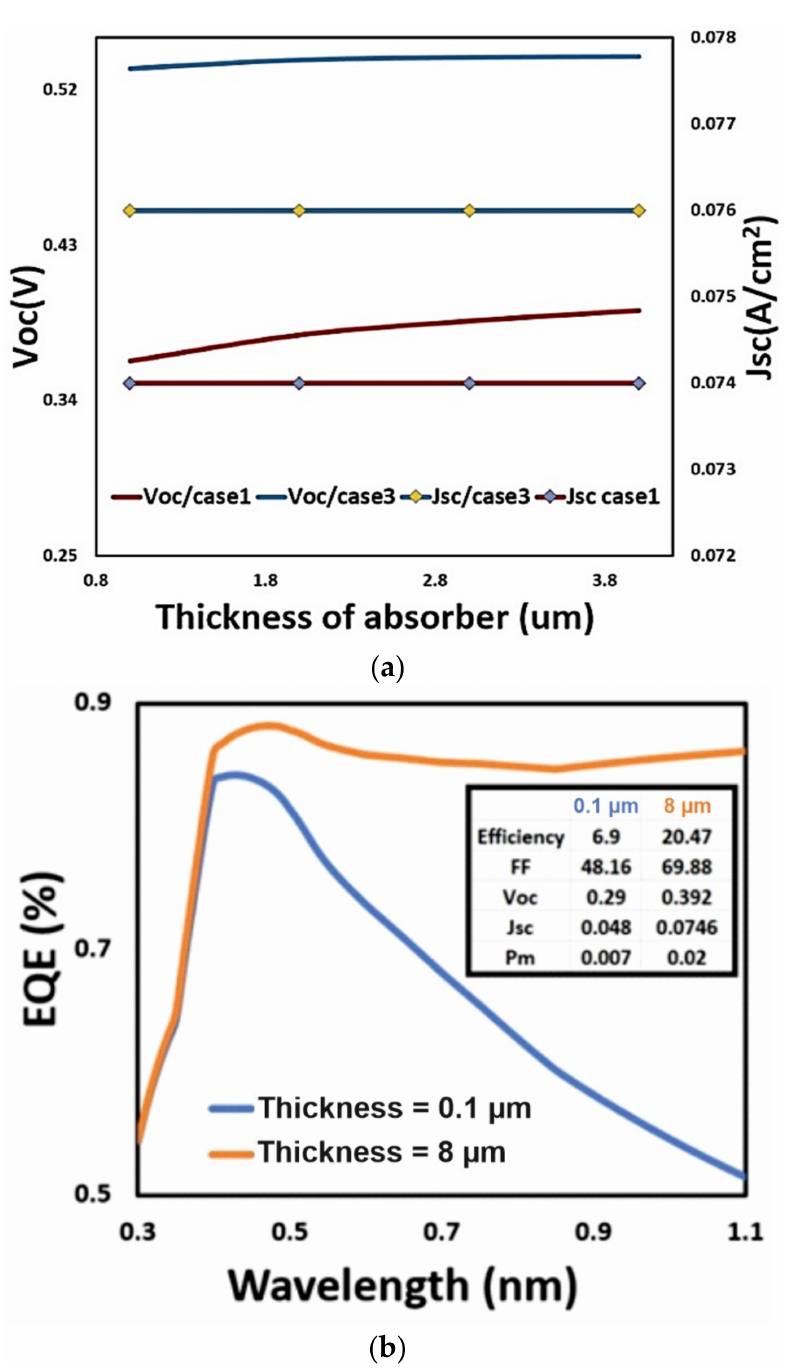
Figure 5. ( a ) Electrical properties versus absorber thickness. ( b ) EQE versus absorber thickness for Case